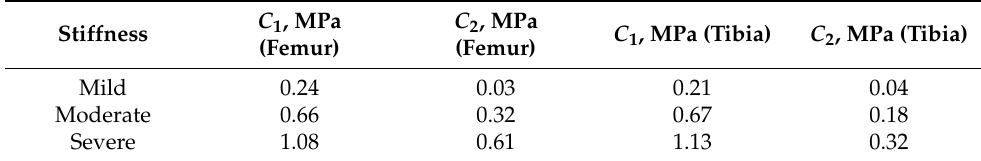
Table 1. Elastic constants of femur and tibia cartilages. C 1 , MPa C 2 , MPa Stiffness (Femur) Mild 0.24 0.03 0.04 Moderate 0.66 0.32 0.18 Severe 1.08 0.61 1.13 0.32 Severe